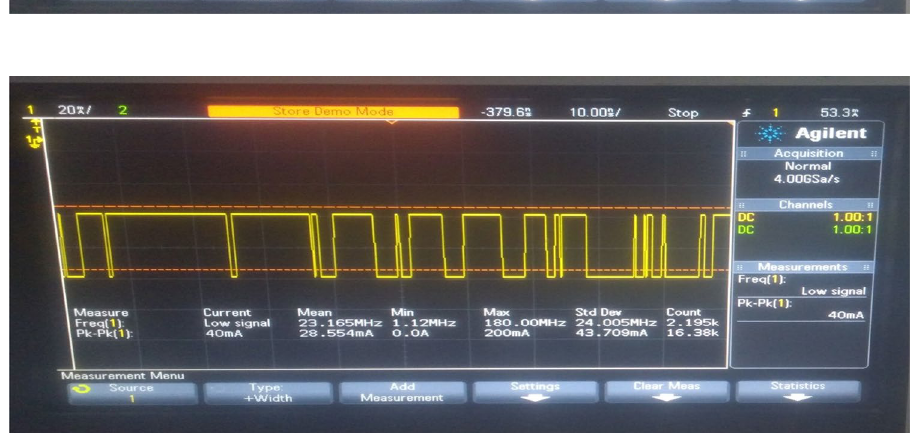
Fig. 17 TRNG output wave- form of FAT-2